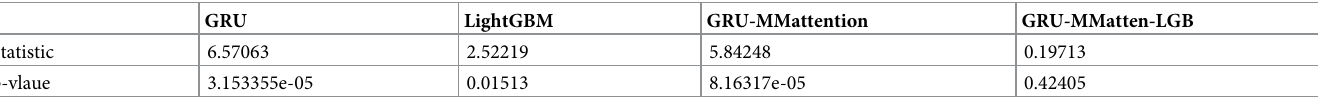
Table 8. The results of the t